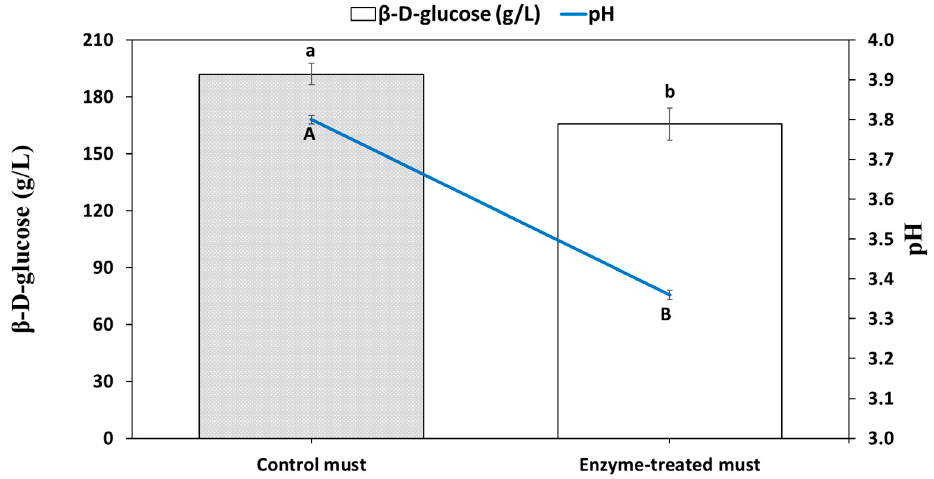
Figure 6. Glucose concentration and pH of the control and the enzyme-treated musts. Bars with different letters are significantly different at p ≤ 0.05.